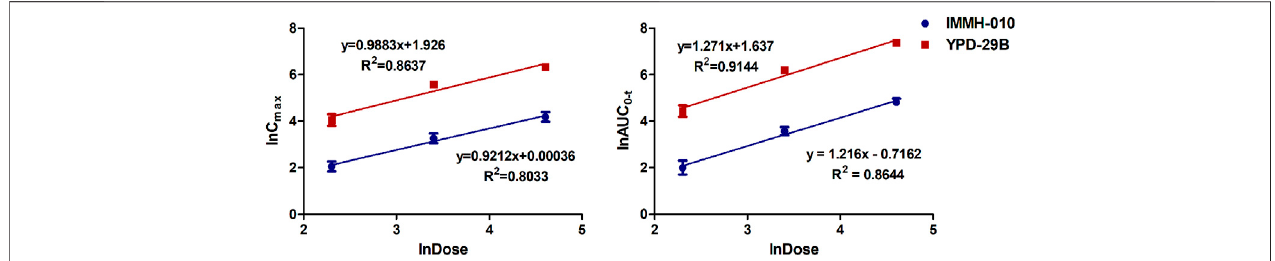
FIGURE 4 | Does proportionality of C max (left) and AUC 0-t (right) for IMMH-010 and YPD-29B in plasma with a single i. g. administration of IMMH-010 maleate at doses of 10, 30, 100 mg/kg.